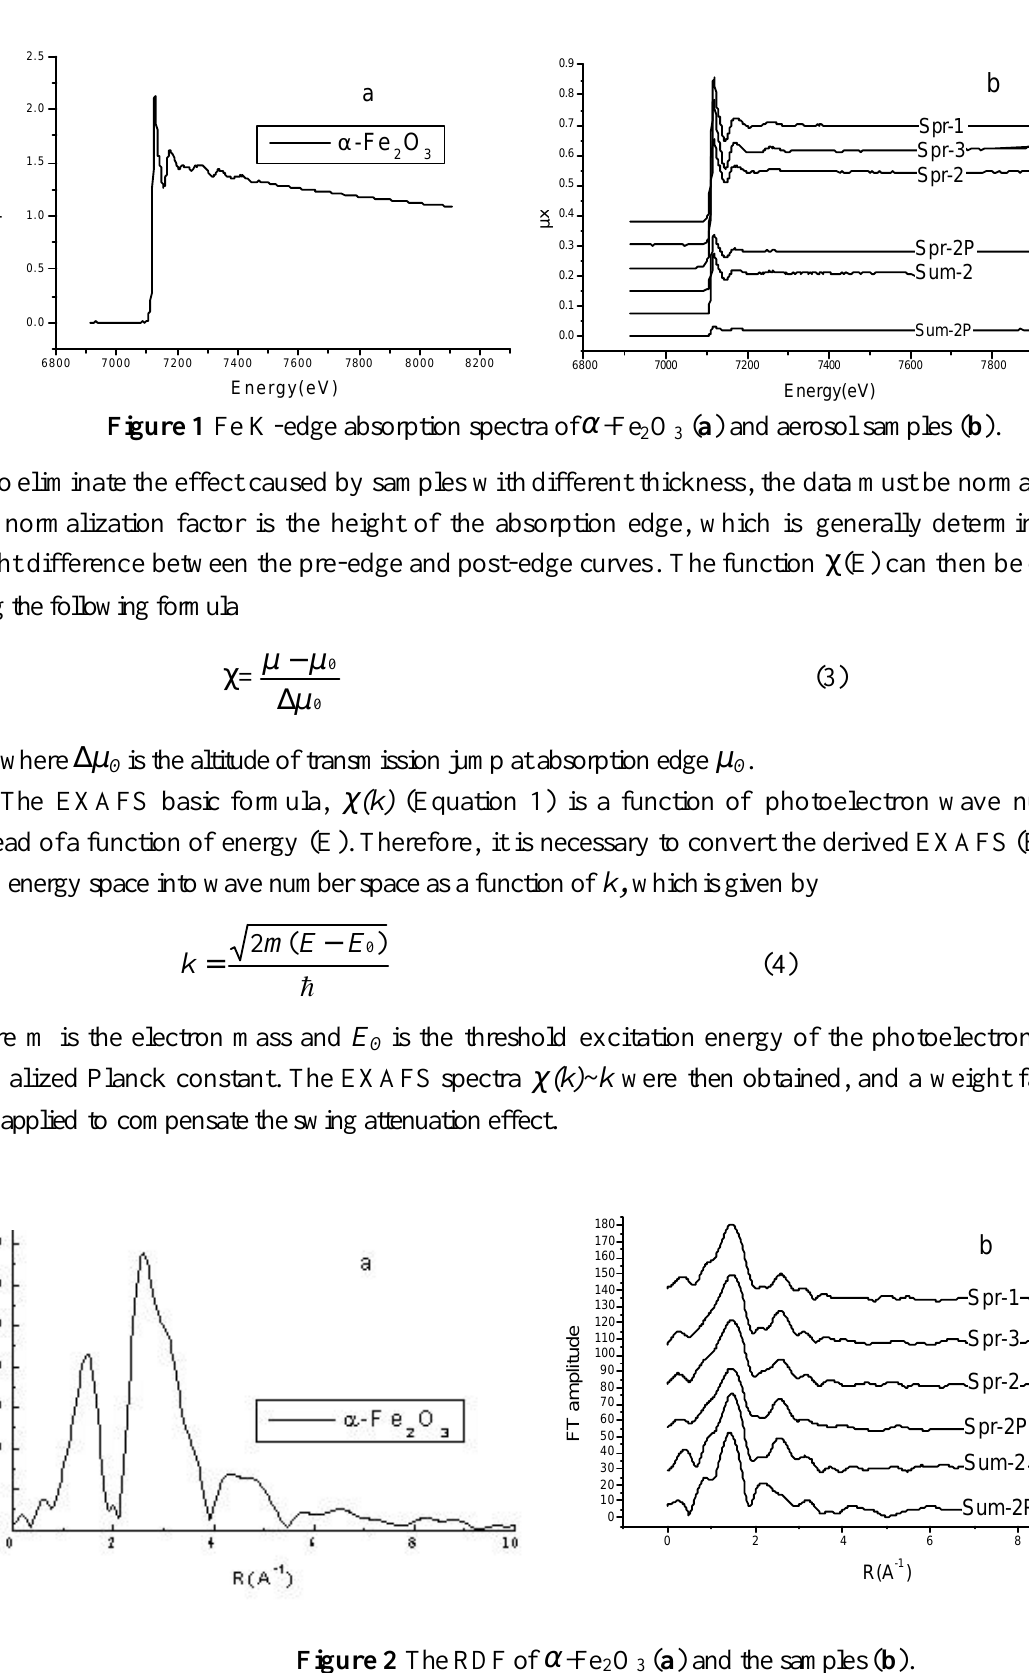
Figure 2 The RDF of a - Fe 2 O 3 ( a ) and the samples ( b